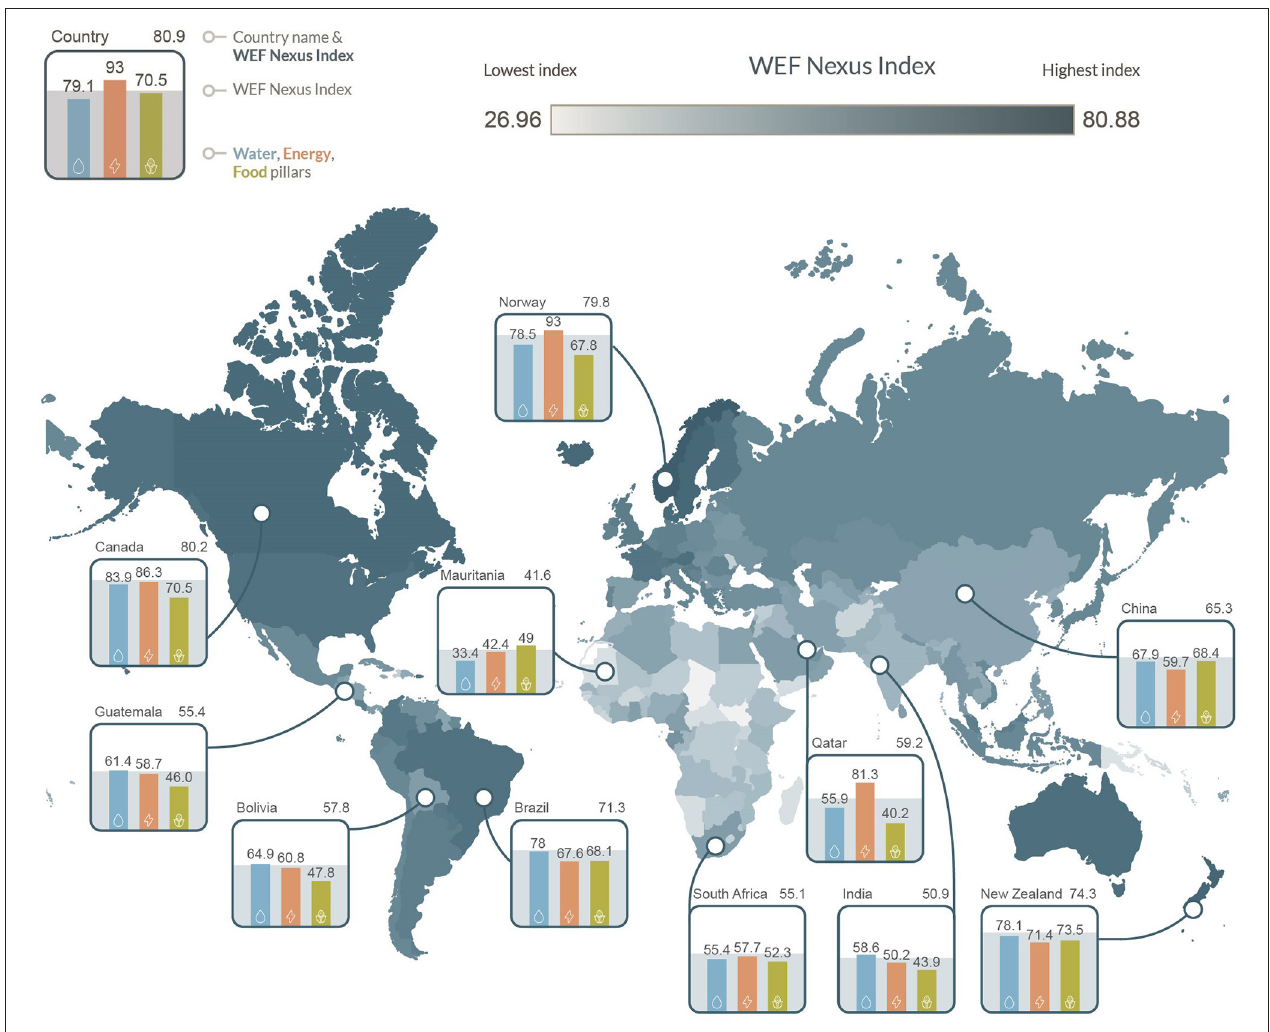
FIGURE 4 | WEF Nexus Index world map with a focus (in glyphs) on selected countries (interactive website at https://www.wefnexusindex.org/). Latest available data as of August 2019. Figures S1–S21 in Addendum E . In Addendum F , the